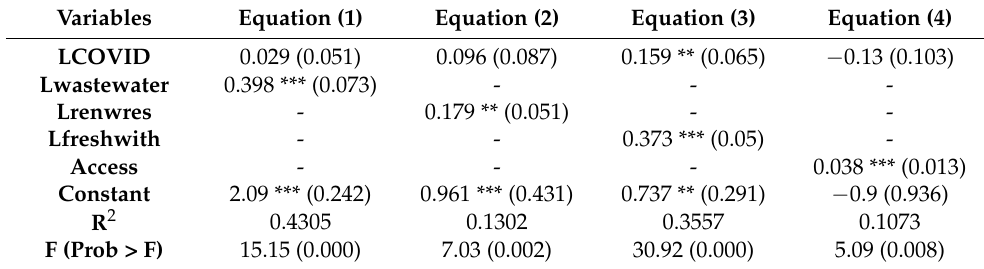
Table 6. Robust regression results.